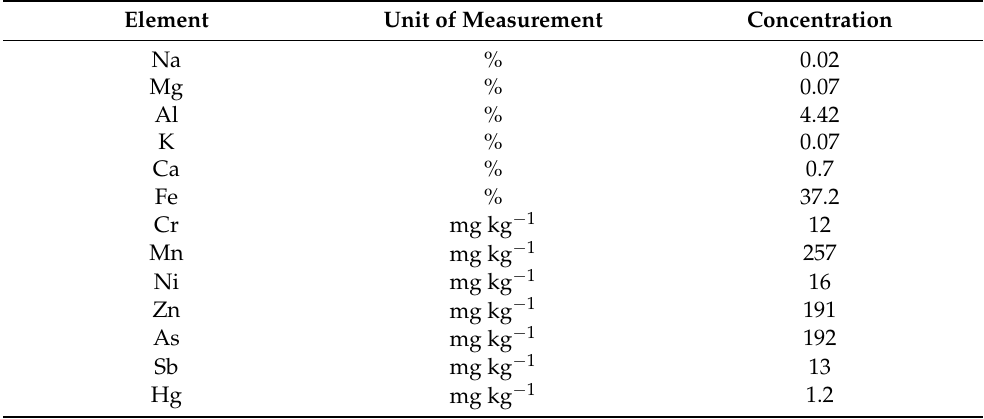
Table 3. Major (wt.%) and trace element (mg kg − 1 ) in the sediment precipitating from the Galleria Italia waters.